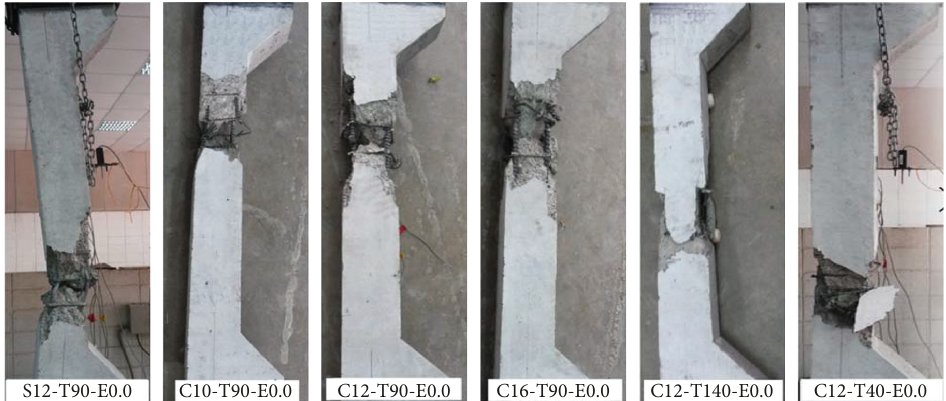
Figure 4: Crack pattern and mode of failure of concentric column